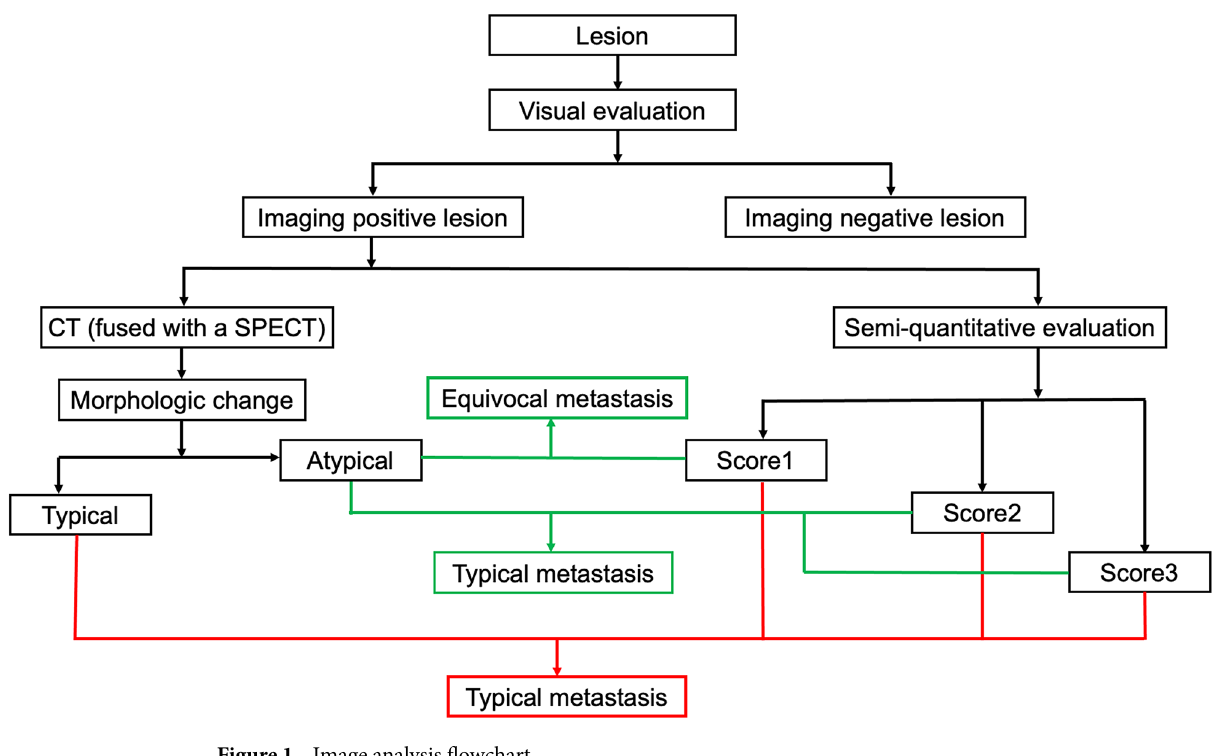
Figure 1. Image analysis